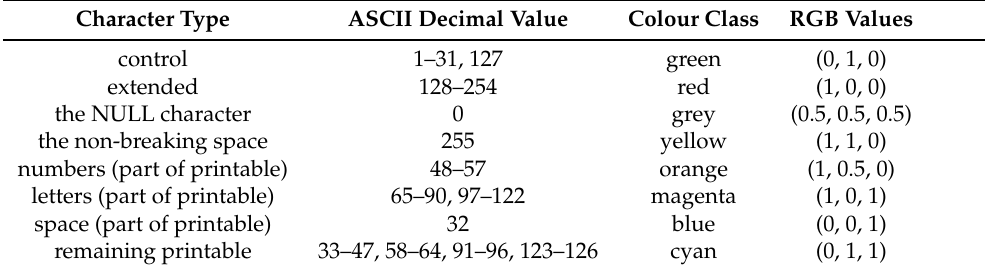
Table 1. The colours and their corresponding RGB values for the 7 categories of the ASCII